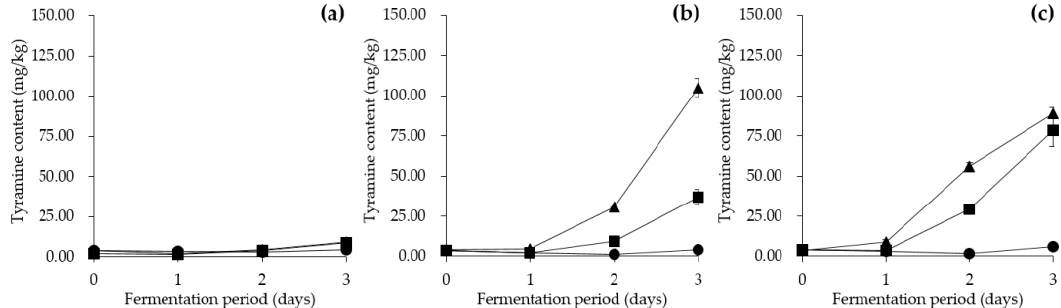
Figure 5. Effect of fermentation temperature on tyramine content in Cheonggukjang inoculated with ( a ) B. subtilis KCTC 3135, ( b ) B. subtilis KCTC 3135 and E. faecium KCCM 12118, and ( c ) B. subtilis KCTC 3135 and E. faecium CJE 216. ● : 25 °C, ■ : 37 °C, ▲ : 45 °C. Error bars indicate standard